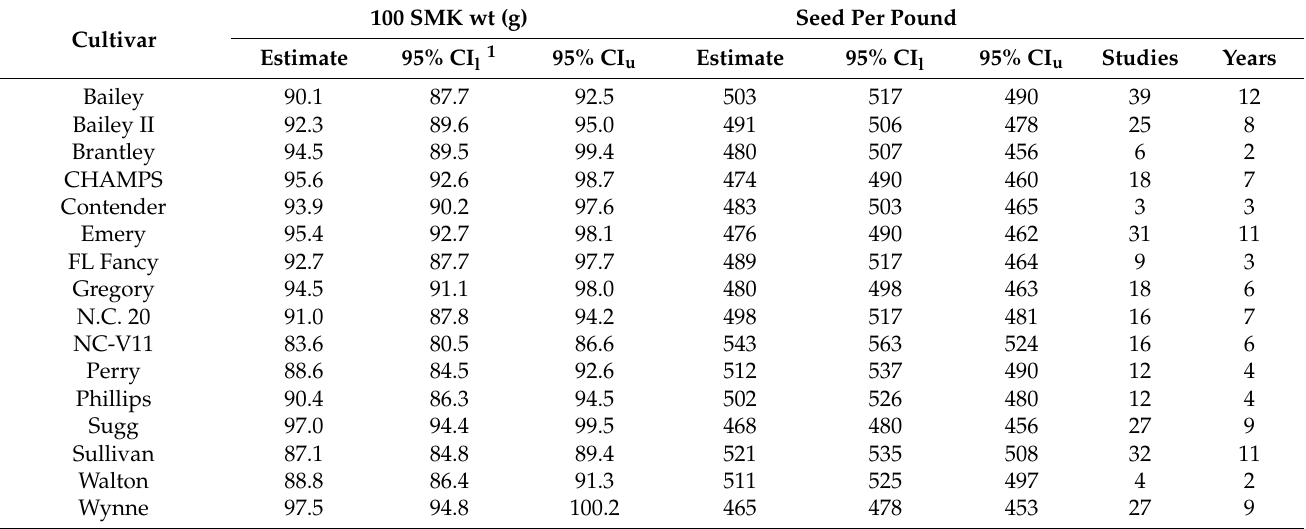
Table 3. Virginia market type cultivar 100 sound mature kernel (SMK) weight and corresponding number of seed per pound estimated from field trials conducted in North and South